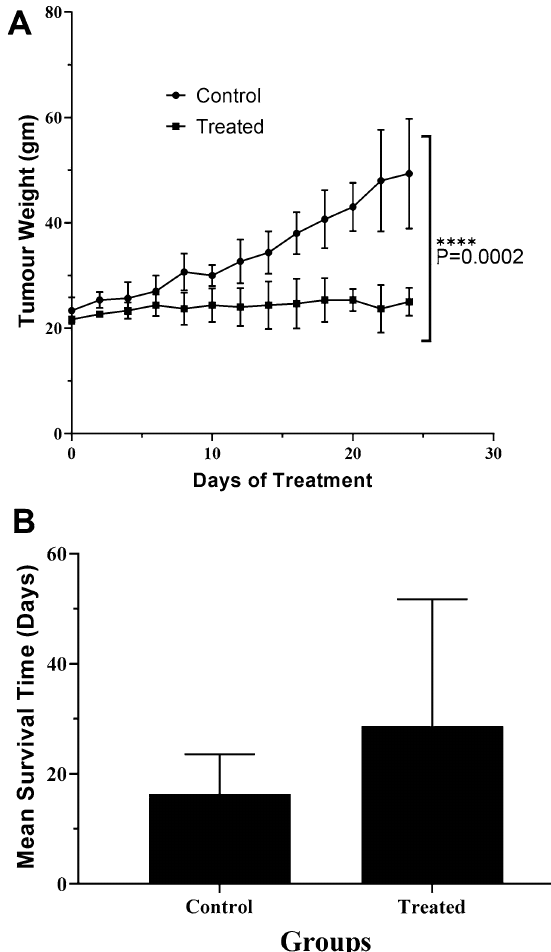
Figure 7. Average tumor weight and life span. Changes of average tumor weight ( A ) and increase in life span ( B ) after treatment with the G. densiflorum